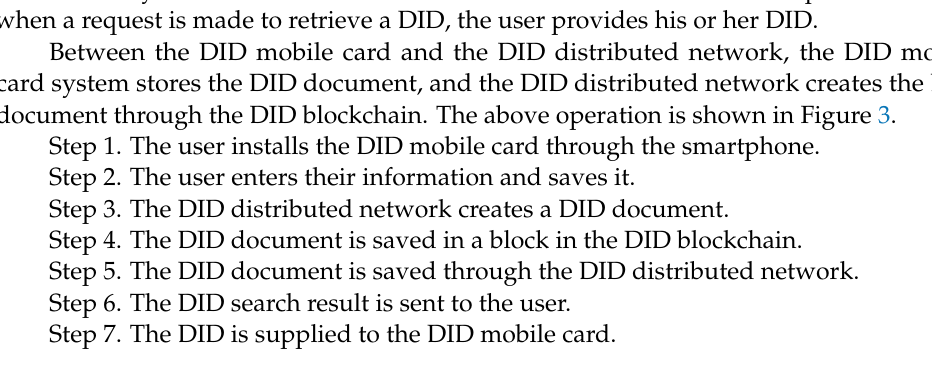
Figure 4. Details of the DID authentication network.